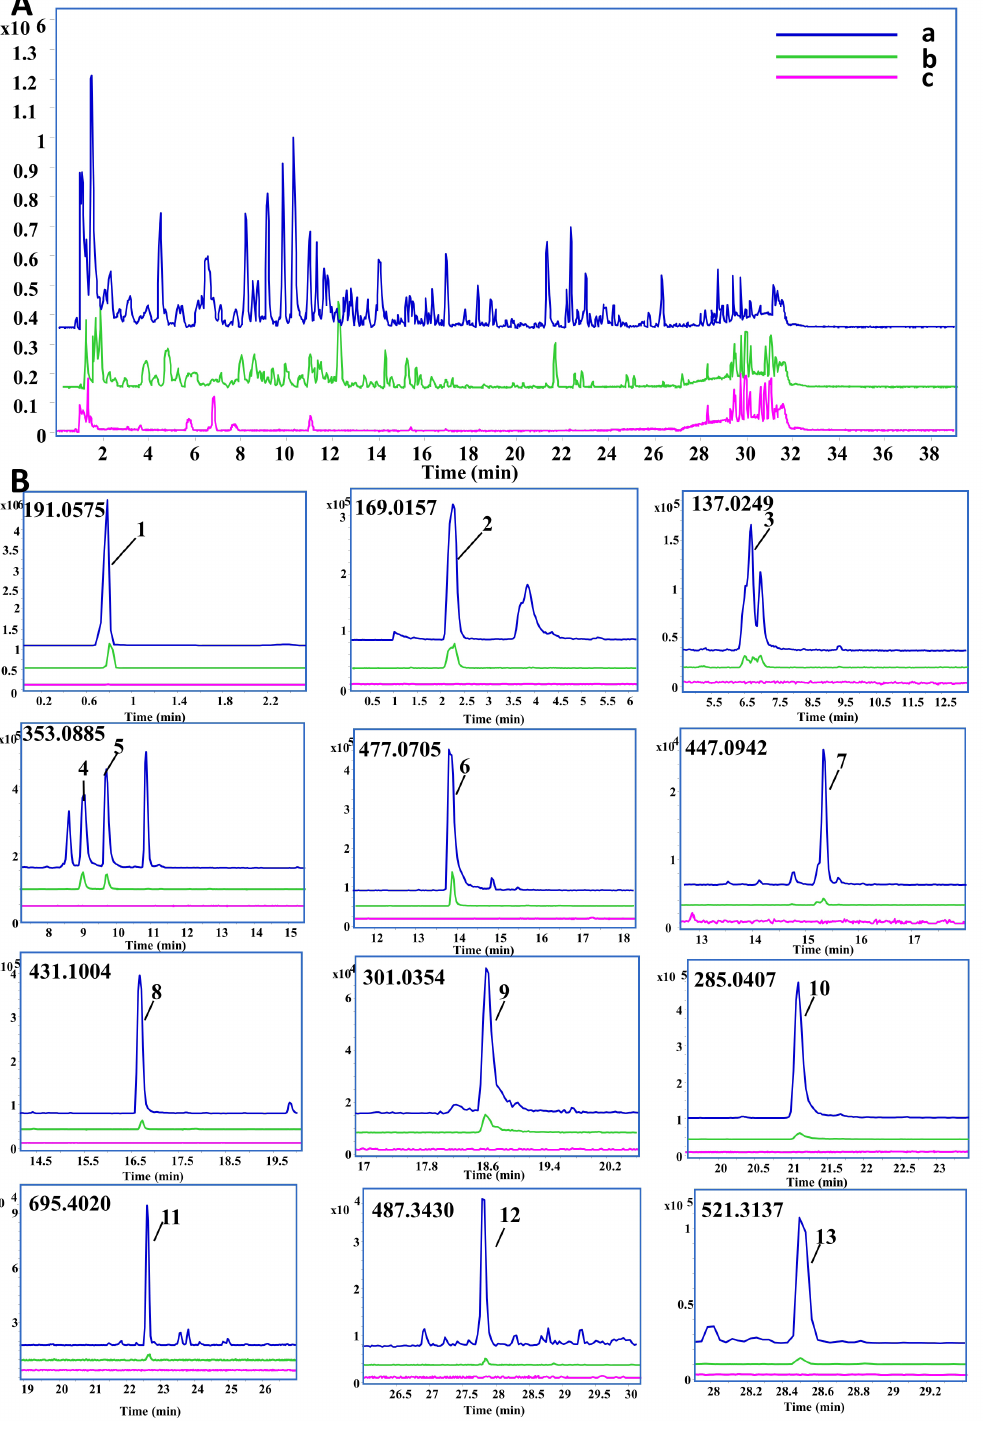
Figure 1: The total ion chromatograms of the chemical constituents in rat serum followed by oral administration of CP extract. Total ion chromatograms (TICs) in negative mode of CP extract (a, blue line), serum samples of rats following oral administration of CP extract for 30 minutes (b, green line), and blank plasma samples (c, purple line). (A) The overall profile of ion chromatograms; (B) Enlarged ion chromatograms of potential active absorbed